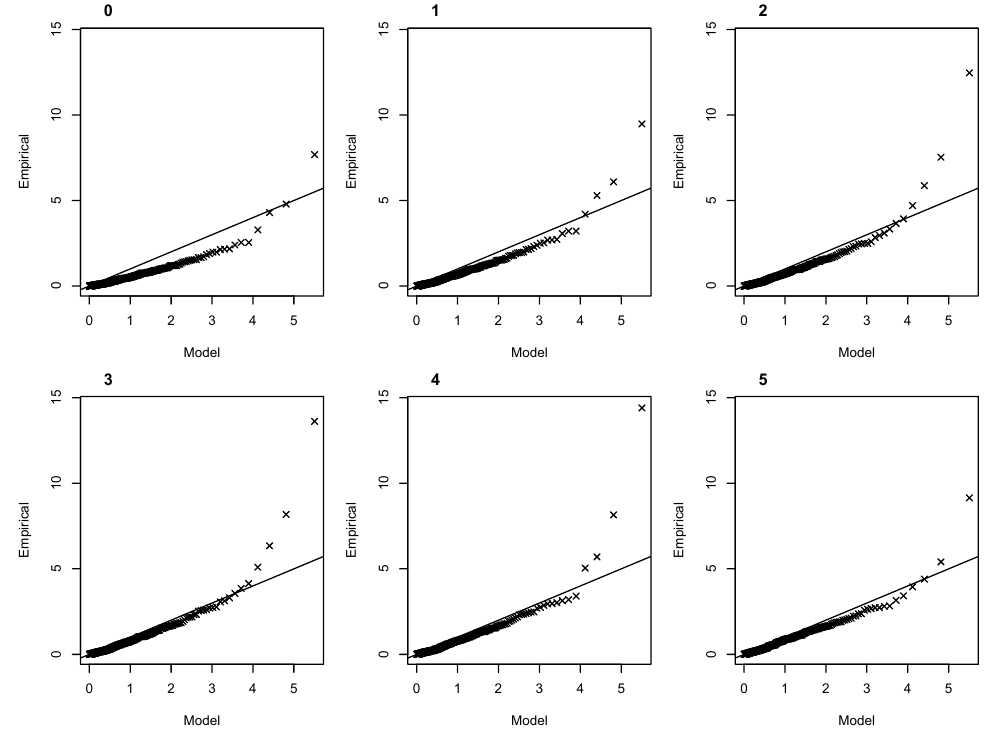
Figure 7. Quantile–quantile plots for the best NHPP model for S at each step of the mixed selection with a constant shape parameter (i.e., Models 0 to 5 of Table